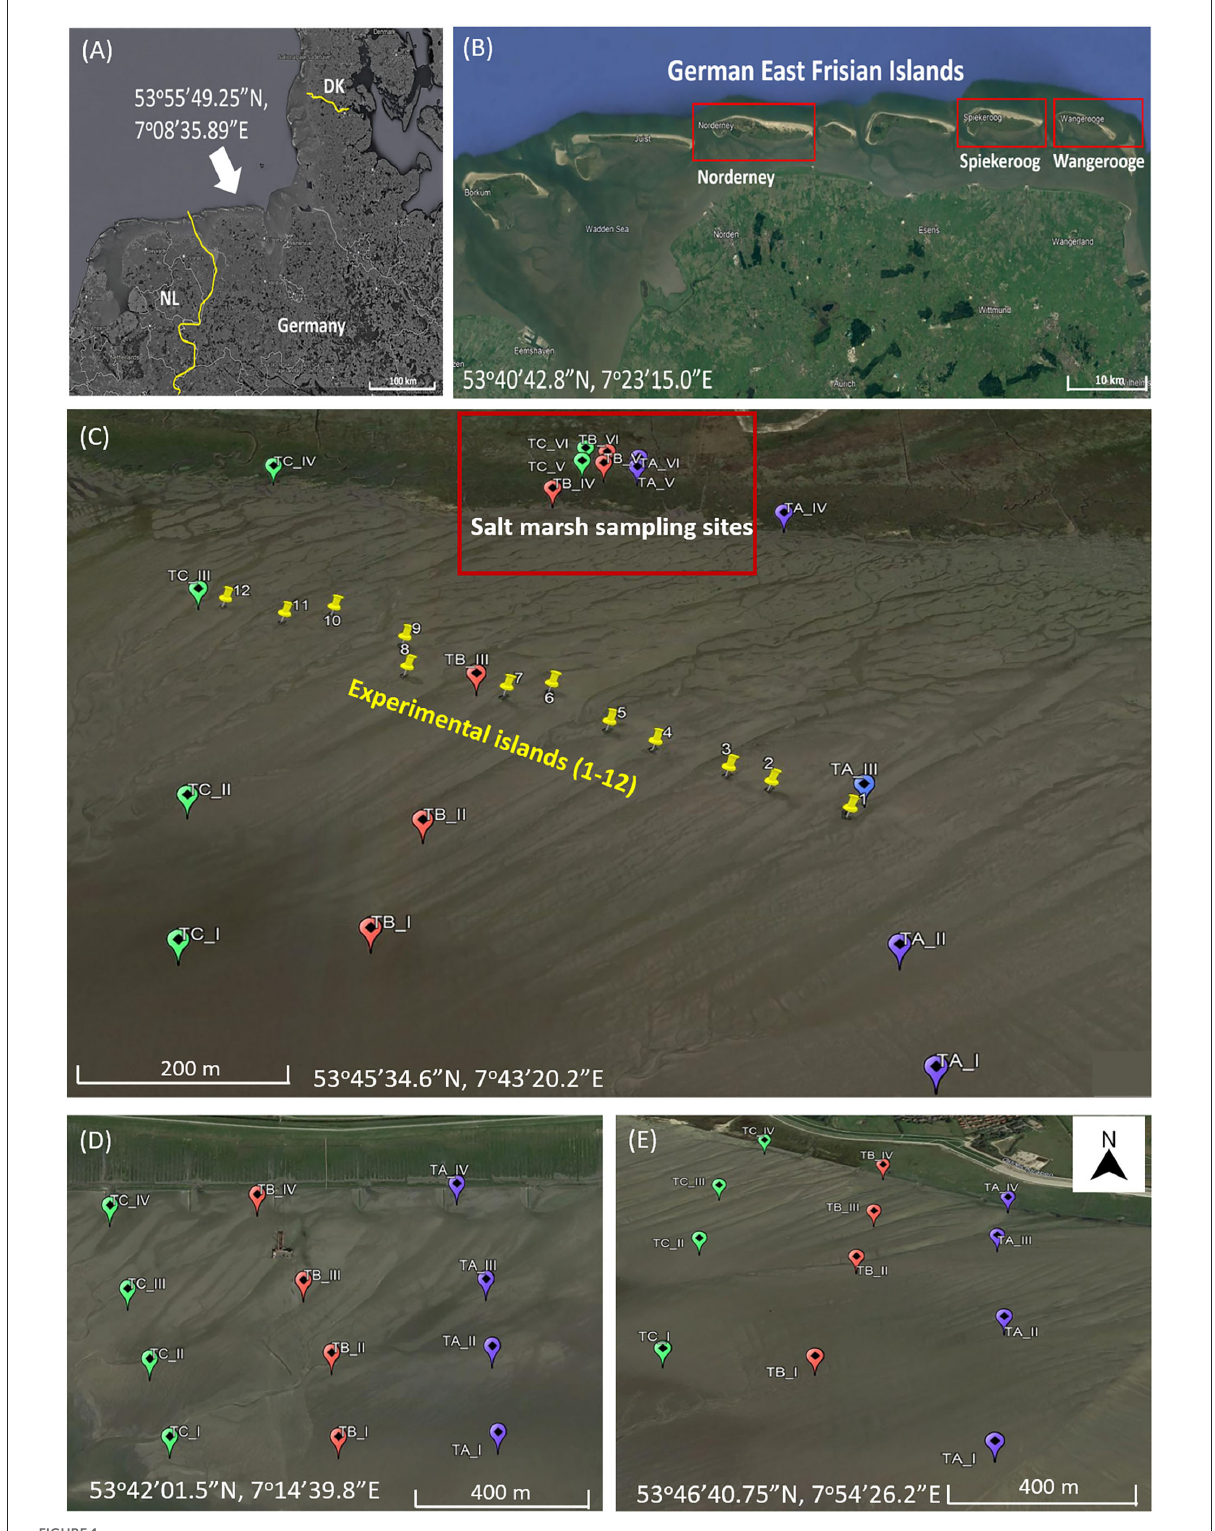
FIGURE1 (A) Location of the East Frisian Islands on the north-western coast of Germany, in the state of Lower Saxony. (B) Close-up view (marked in red) of the three East Frisian Islands involved in this study (L-R) Norderney, Spiekeroog, and Wangerooge. (C) Close up image of individual sampling sites (I-VI) and transects A to C on Spiekeroog. Included also are the sites of the twelve experimental islands (shown as yellow pins). (D,E) Close up images of sampling sites on Norderney and Wangerooge, respectively. All images are modified Google Earth satellite images. GPS coordinates of individual sampling sites are listed in the Supplementary